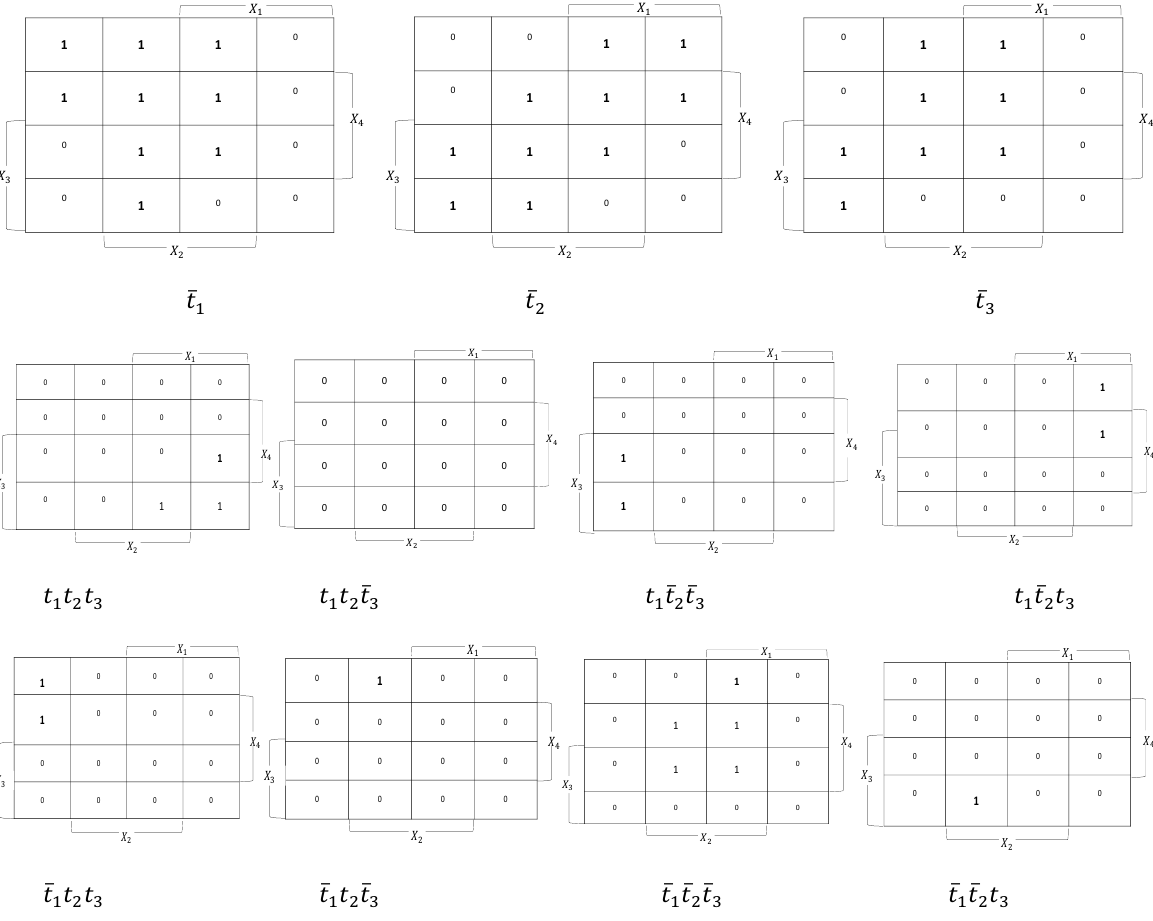
Fig. 19. Conventional Karnaugh maps used in the evaluation of entries in Fig. 18